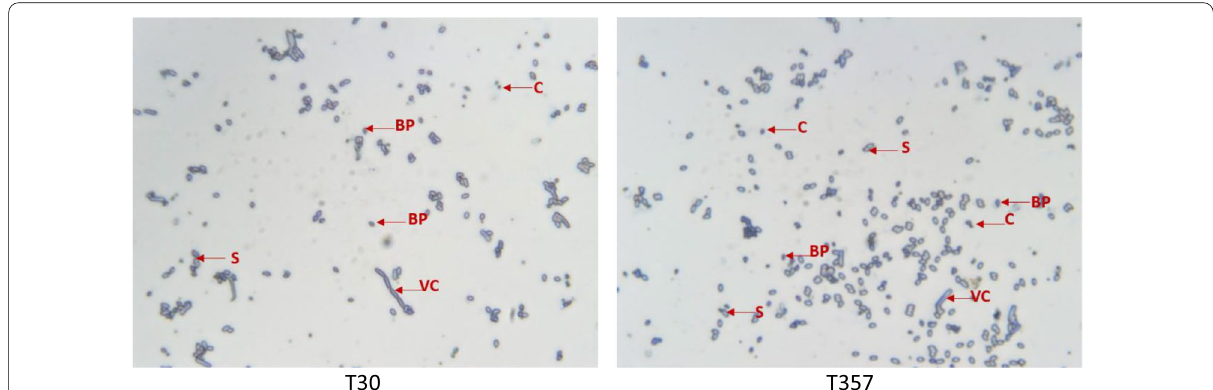
Fig. 1 Spore-crystal inclusions of Bt isolates observed under a bright-field microscope (100 cuboidal;